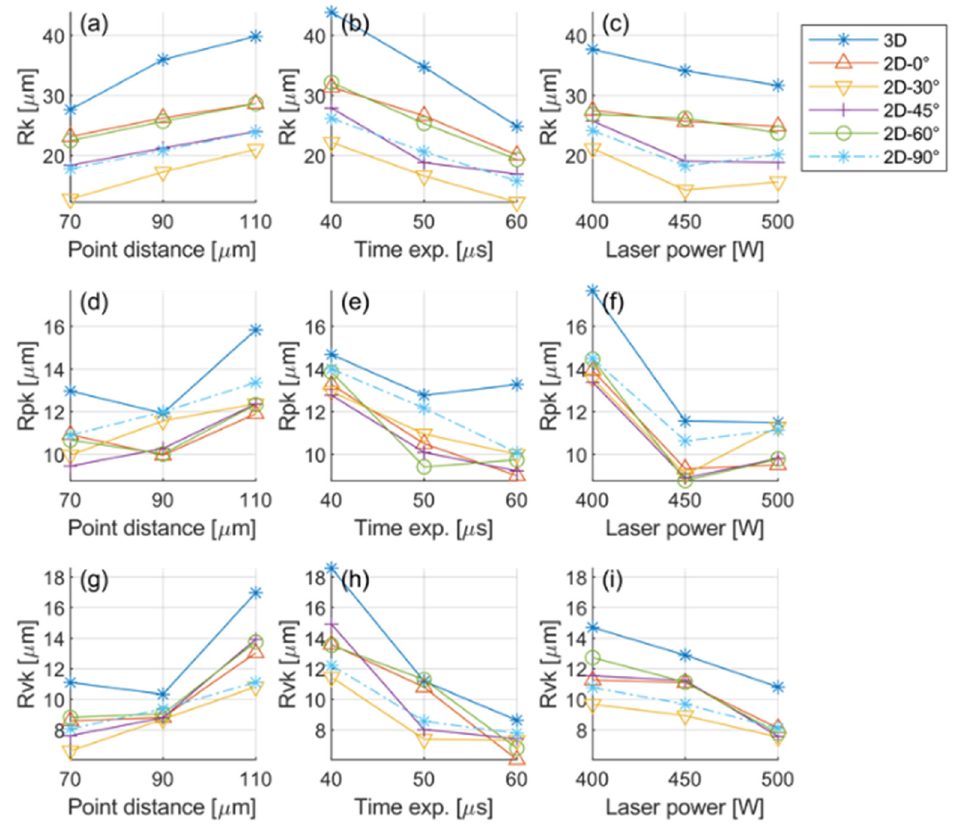
Figure 8. Influence of process parameters on ( a - c ) Rk, ( d - f ) Rpk and ( g - i ) Rvk. Effect of ( a , d , g ) point distance, ( b , e , h ) time exposure (exp.) and ( c , f , i ) laser power.